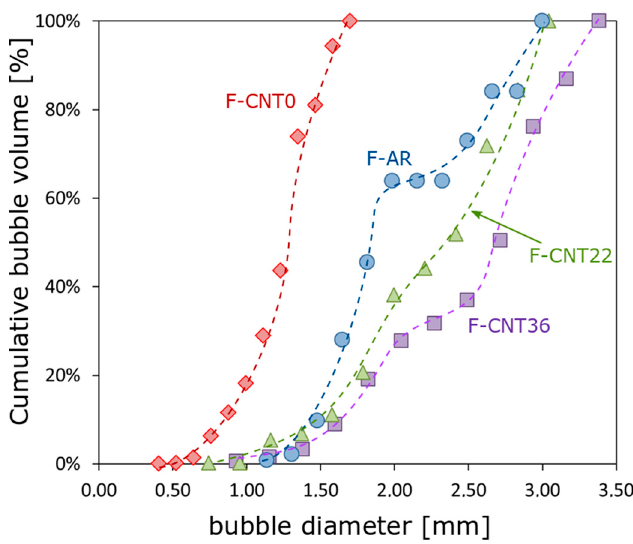
Figure 7. Cumulative bubble volume evolution at varying diameter for all composite foams.